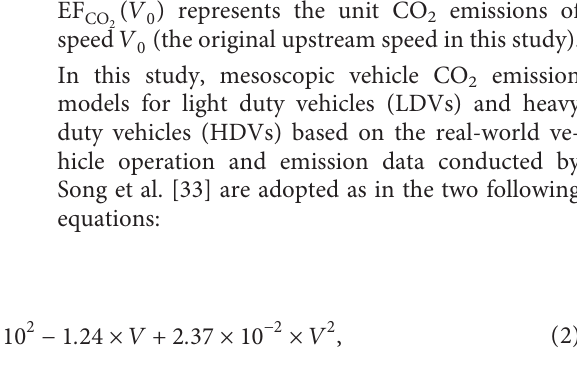
2 emissions computation